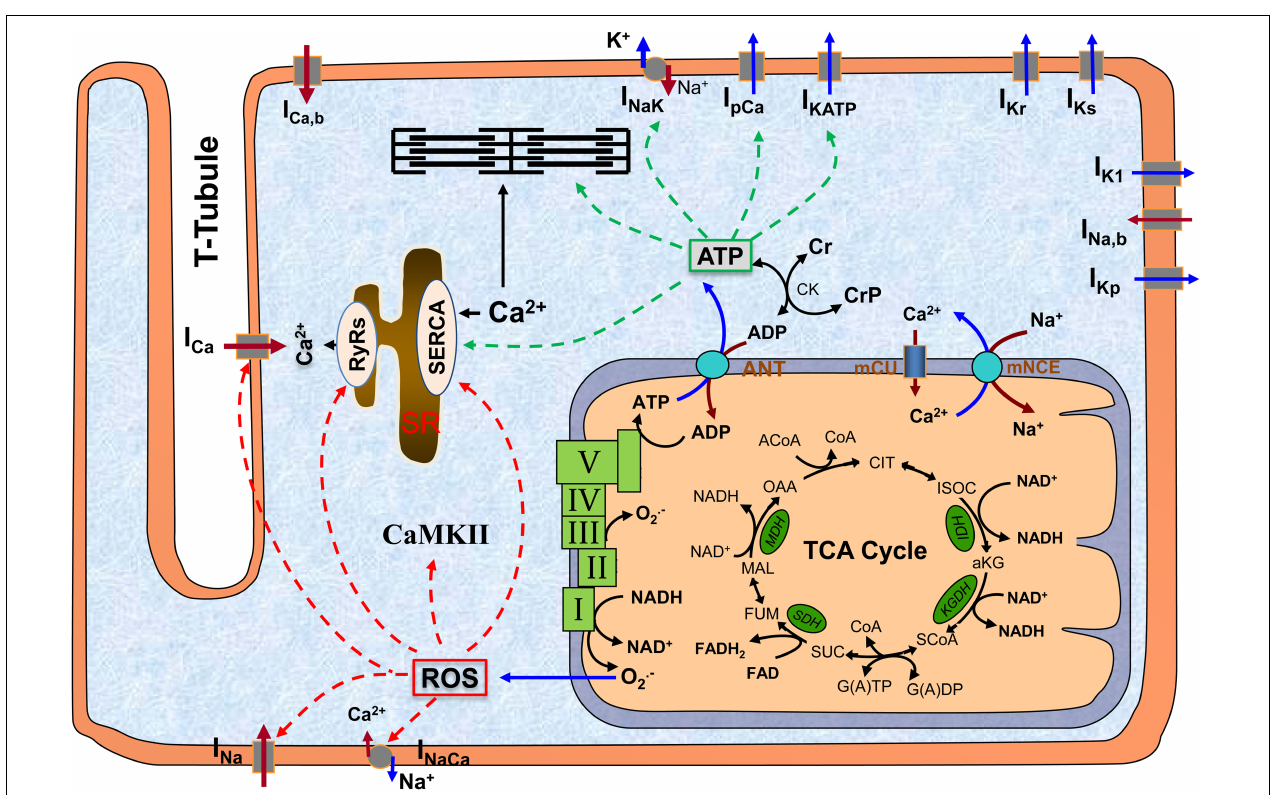
FIGURE 1 | The scheme of mitochondrion and its interaction with other subcellular systems in cardiomyocyte. The major function of mitochondrion is to produce ATP, which occurs at complex V ( a.k.a. F0F1 ATPase) using the electrochemical gradient generated by electron transport chain (complex I to IV). A byproduct of ATP production is superoxide (O . − 2 ), which is probably generated at complex I and complex III. ATP is translocated to cytosol via ANT and hydrolyzed to support excitation-contraction and energy-sensitive ion transporters (indicated by green dashed lines). O . − 2 can freely diffuse to cytosol and form ROS, which can modify a variety of redox sensitive ion transporters (indicated by red dashed lines). Altogether, mitochondrial dysfunction-associated ATP depletion and ROS accumulation can significantly affect cellular action potentials and ion homeostasis. ROS, reactive oxygen species; CaMKII, Ca 2 + /calmodulin-dependent protein kinase II; SR, sarcoplasmic reticulum; TCA, tricarboxylic acid; ANT, adenine nucleotide translocator; mCU, mitochondrial Ca 2 + uniporter; mNCE, mitochondrial Na + /Ca 2 + exchanger; I–V, complex I to complex